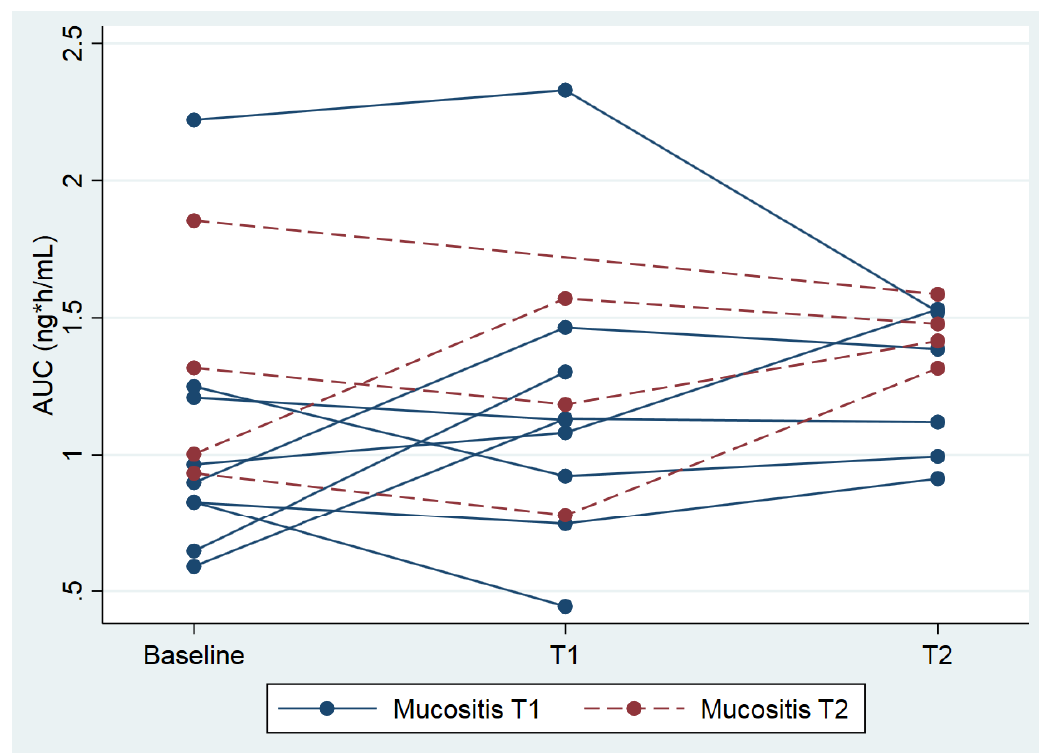
Figure 1. Individual area under the curve (AUCs) plotted against three time points; baseline, 3 weeks (T1) and 6 weeks (T2) after start. Each line represents an individual patient. Patients with a blue line had grade ≥2 mucositis at T1 and patients with a red line at T2.